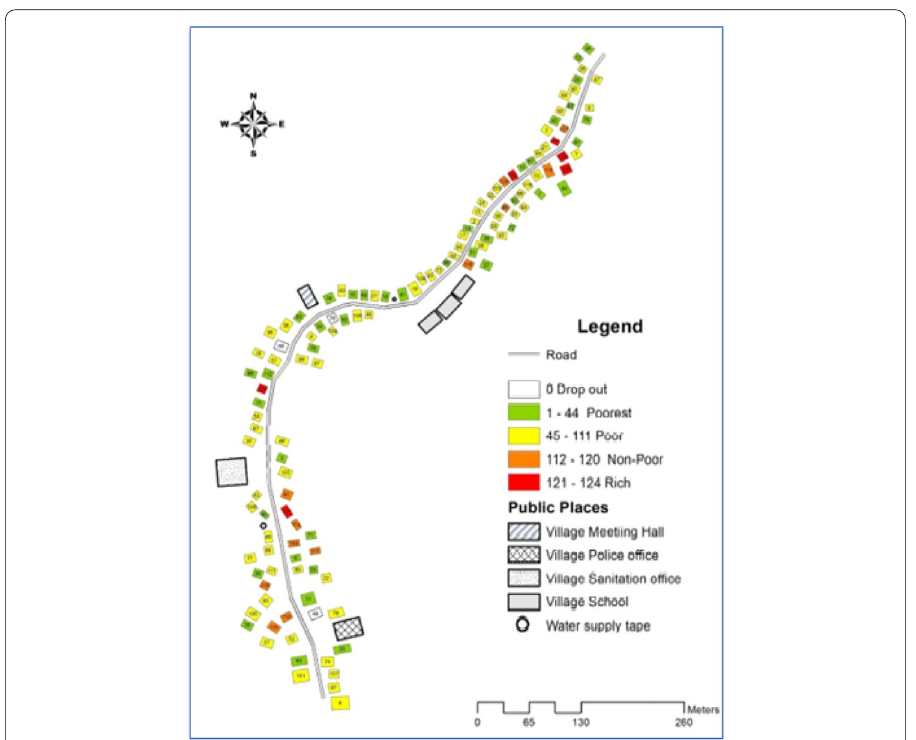
Fig. 2 Individual households in the targeted village (2016). This map was drawn by authors when conducting the household survey, March 2016